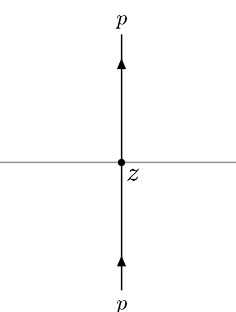
Figure 12. Vertex for the twist-two light-ray operators. This represents a time-folded diagram where the gray horizontal line separates the lower and upper folds. The momentum runs from the lower to upper fold. The black dot on the gray horizontal line is the insertion of D J at null